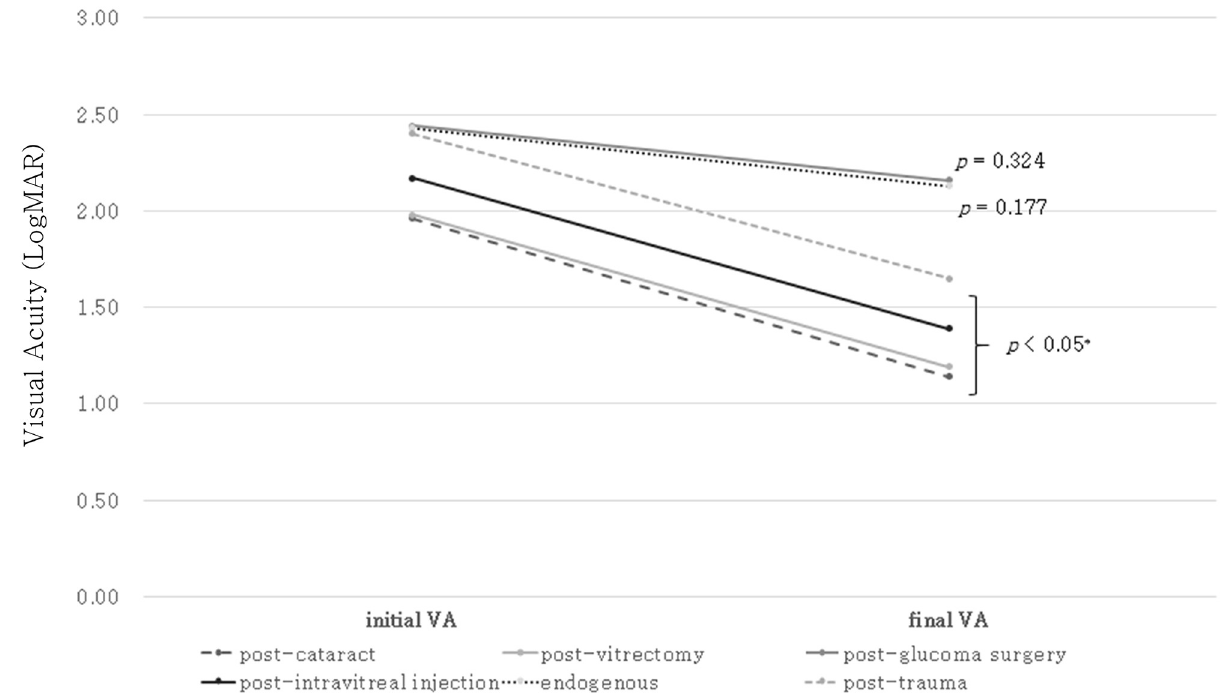
Fig 2. Comparison between initial visual acuity and final visual acuity. Final visual acuity improved after treatment in the post-cataract surgery, post- vitrectomy, post-intravitreal injection, and post-traumatic endophthalmitis groups. However, there was no significant change between initial and final visual acuity in the post-glaucoma surgery and endogenous endophthalmitis groups.